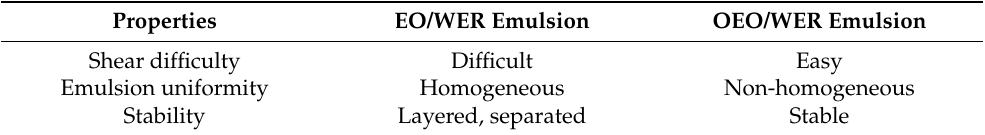
Table 2. Properties of extraction oil/waterborne epoxy emulsion before and after